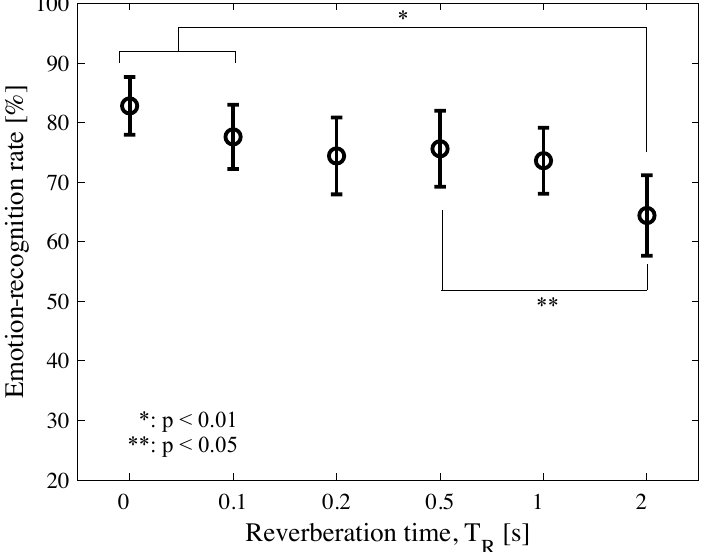
Figure 3. Vocal − emotion − recognition results in reverberant environments [17].